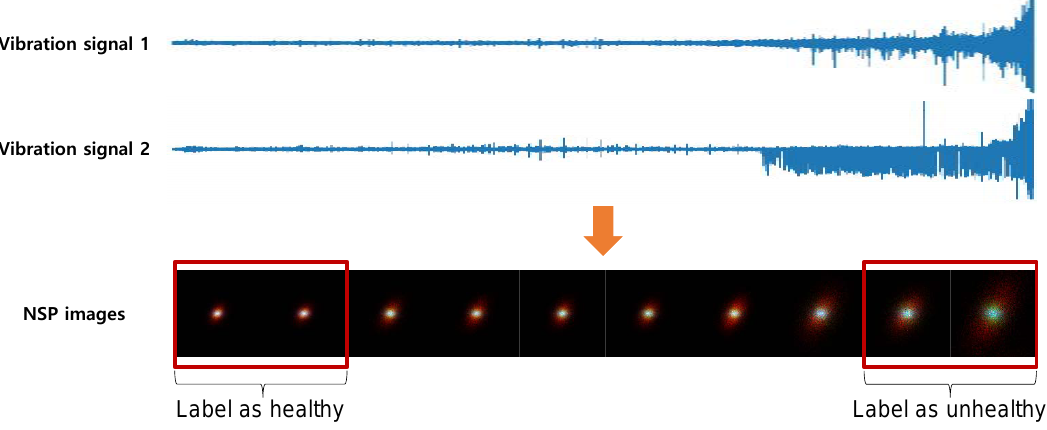
Figure 3. Binary labeling on part of training dataset on bearing wear